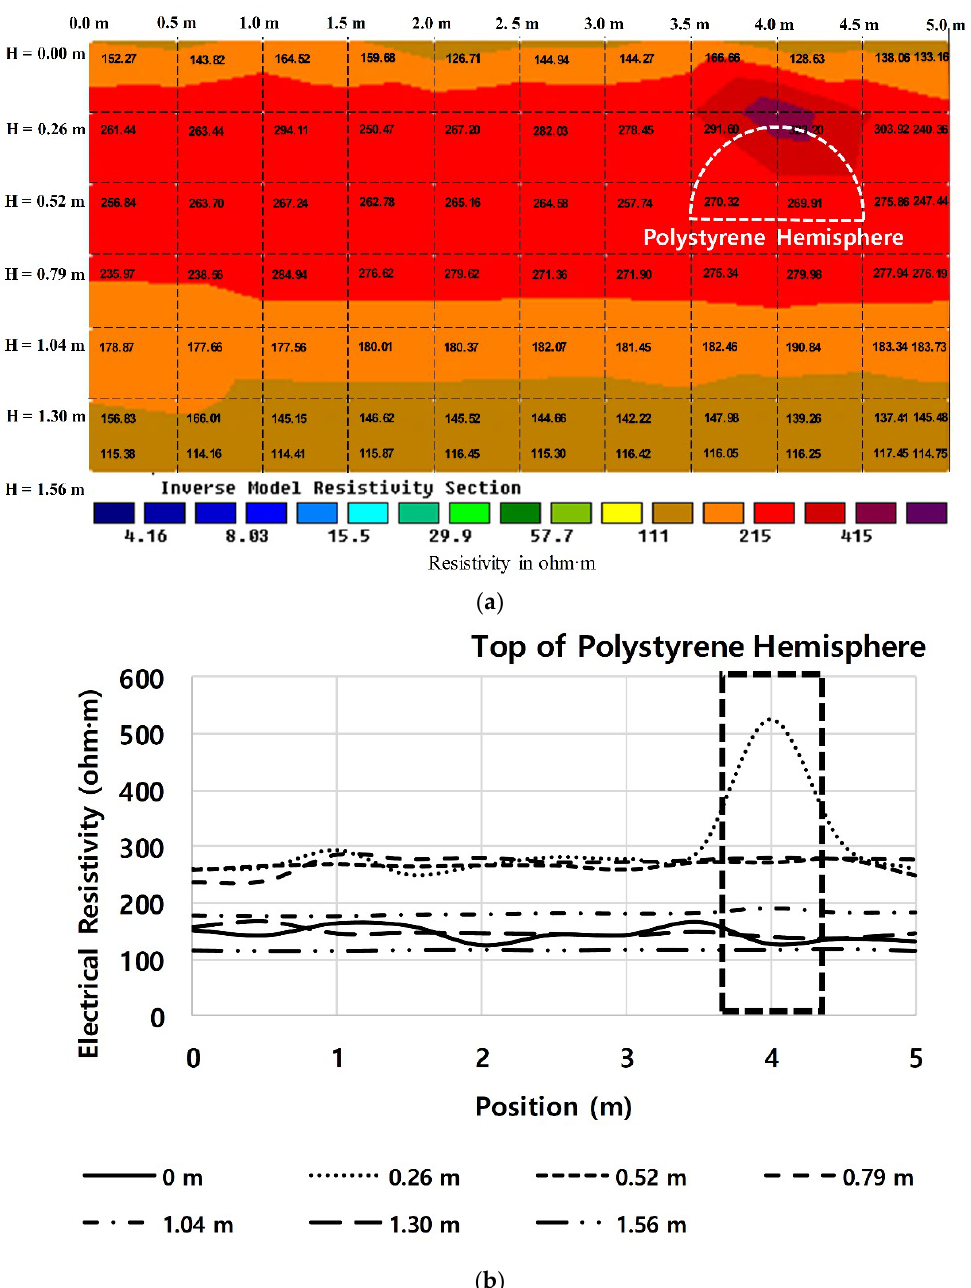
Figure 6. Test result for cavity (Section No. 3). ( a ) Distribution of the ER. ( b ) ER according to the position at each depth.